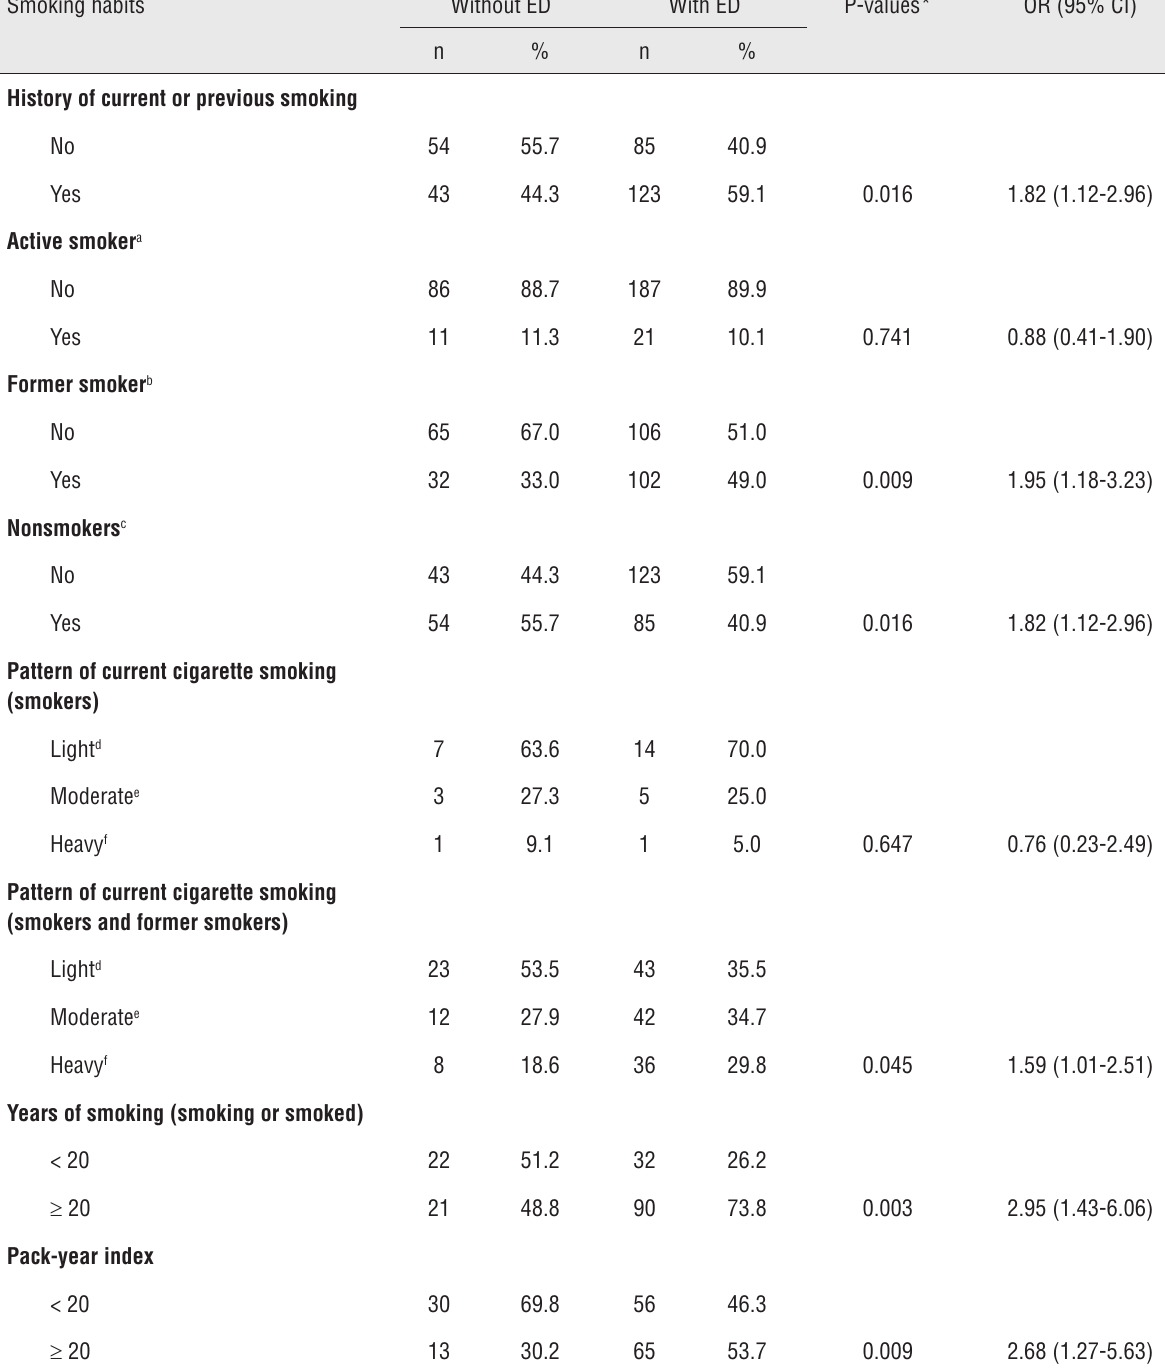
Table 2 - Association of smoking habits with Erectile Dysfunction in hemodialysis patients. Smoking habits Without ED With ED P-values* OR (95% CI) n % n %